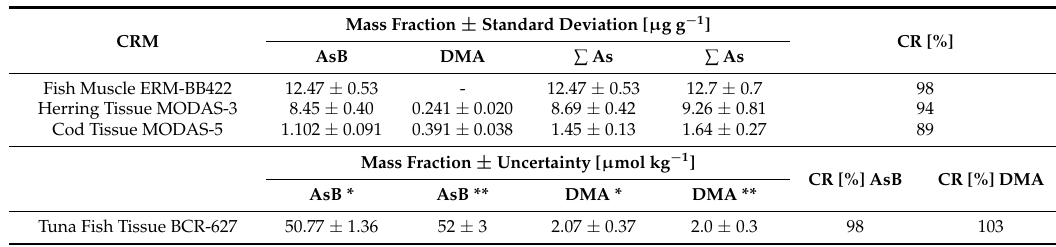
Figure 2. Chromatographic separation obtained for analytes in standards (taken to construct calibration curves) in the range of: 0.5 µg L − 1 to 10.0 µg L − 1 obtained using a mixture of 10 mmol L − 1 of ammonium phosphate and 10 mmol L − 1 of ammonium nitrate as mobile phase. Table 4. Results for As species in certified reference material presented as the average and standard deviations of three replicates of each